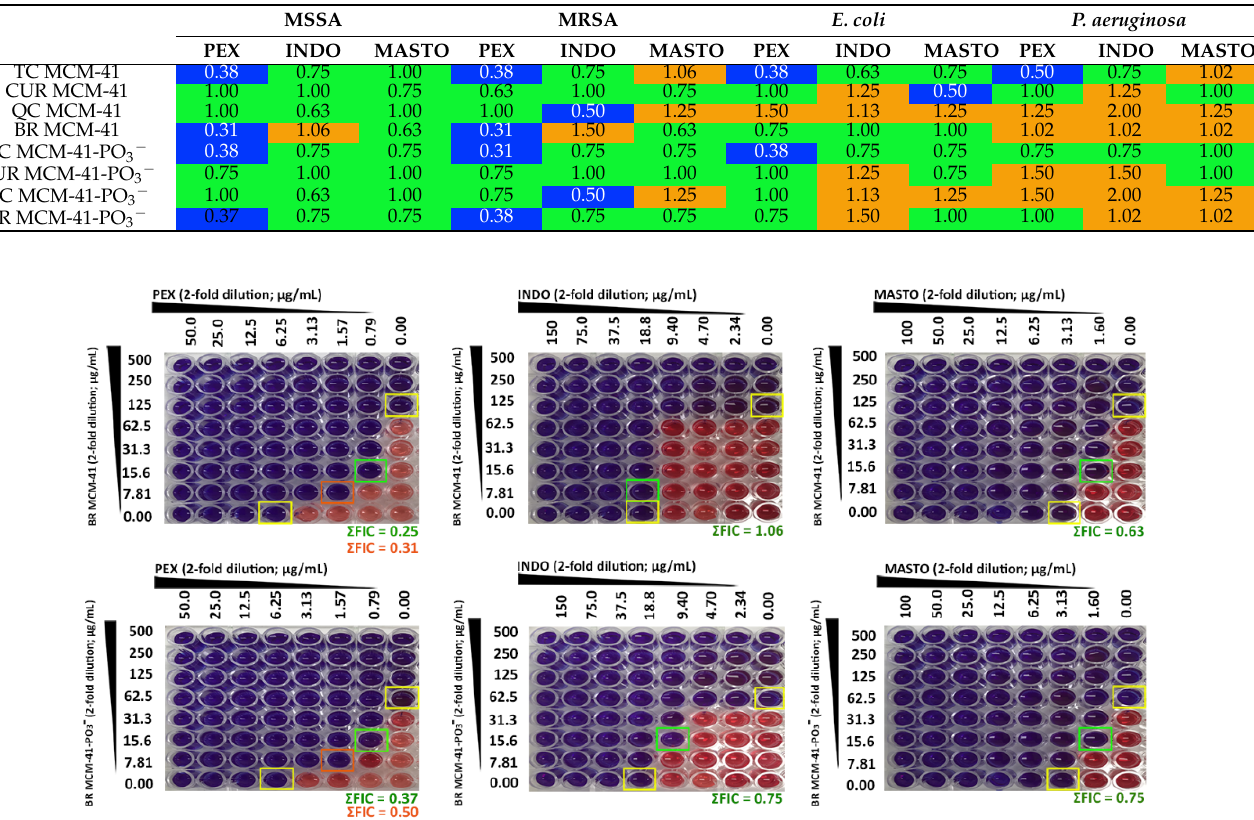
Table 4. FIC index ( Σ FIC) values of SrtAI-loaded MCMs in combination with AMPs (PEX, INDO, and MASTO) against S. aureus ATCC25923 (MSSA), MRSA ATCC43300, E. coli ATCC25922, and P. aeruginosa ATCC27853, as determined by a checkerboard assay. Blue, green, and orange cells indicate synergistic, additive, and indifferent combinations, respectively. The experiment was performed in triplicate, with three independent experiments for each compound to demonstrate reproducibility.